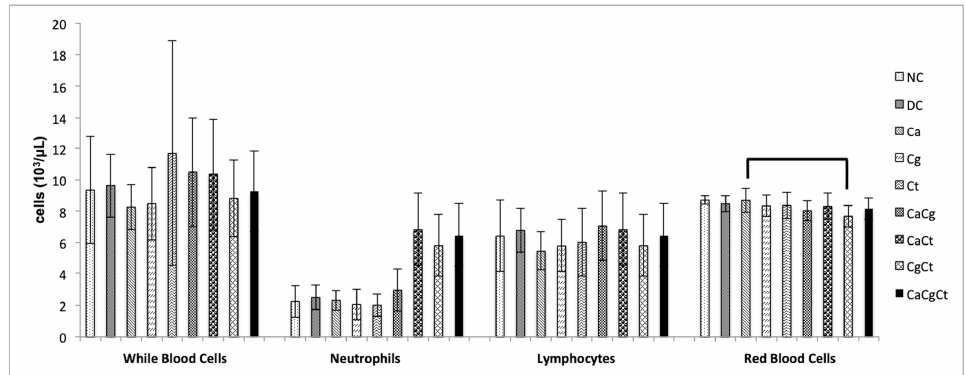
Figure 3. Blood cell counts of male and female rats for each group ( n = 10). Brackets show significant difference between the groups ( p < 0.05). NC: negative control; DC: device control, Ca: Candida albicans , Cg: Candida glabrata , Ct: Candida tropicalis , CaCg: C. albicans + C. glabrata , CaCt: C. albicans + C. tropicalis , CgCt: C. glabrata + C. tropicalis , and CaCgCt: C. albicans + C. glabrata + C. tropicalis groups.